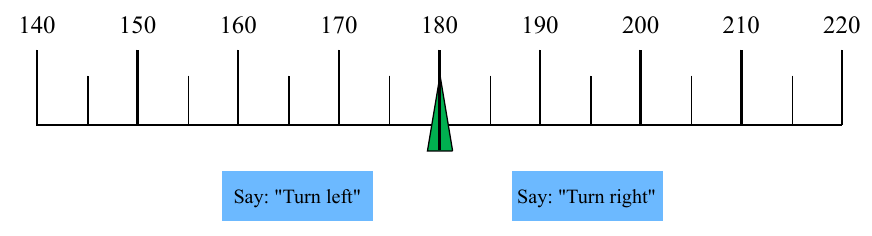
Figure 3. AR Heading